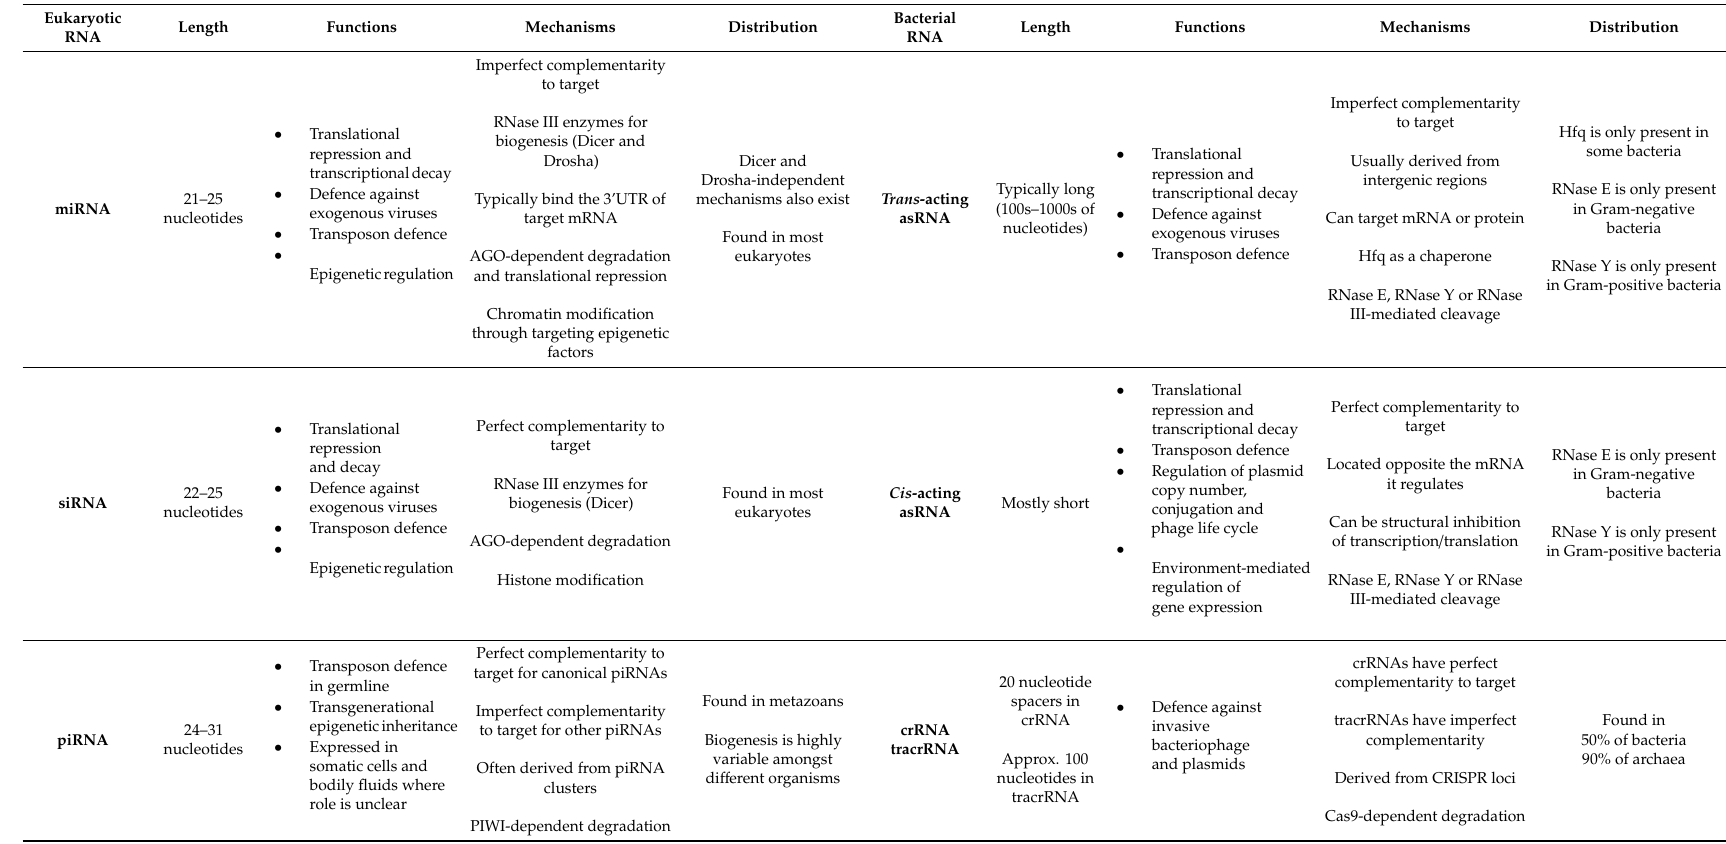
Table 1. Illustrating the similarities between eukaryotic and bacterial antisense RNA-mediated regulatory pathways. Eukaryotic RNA Length Length